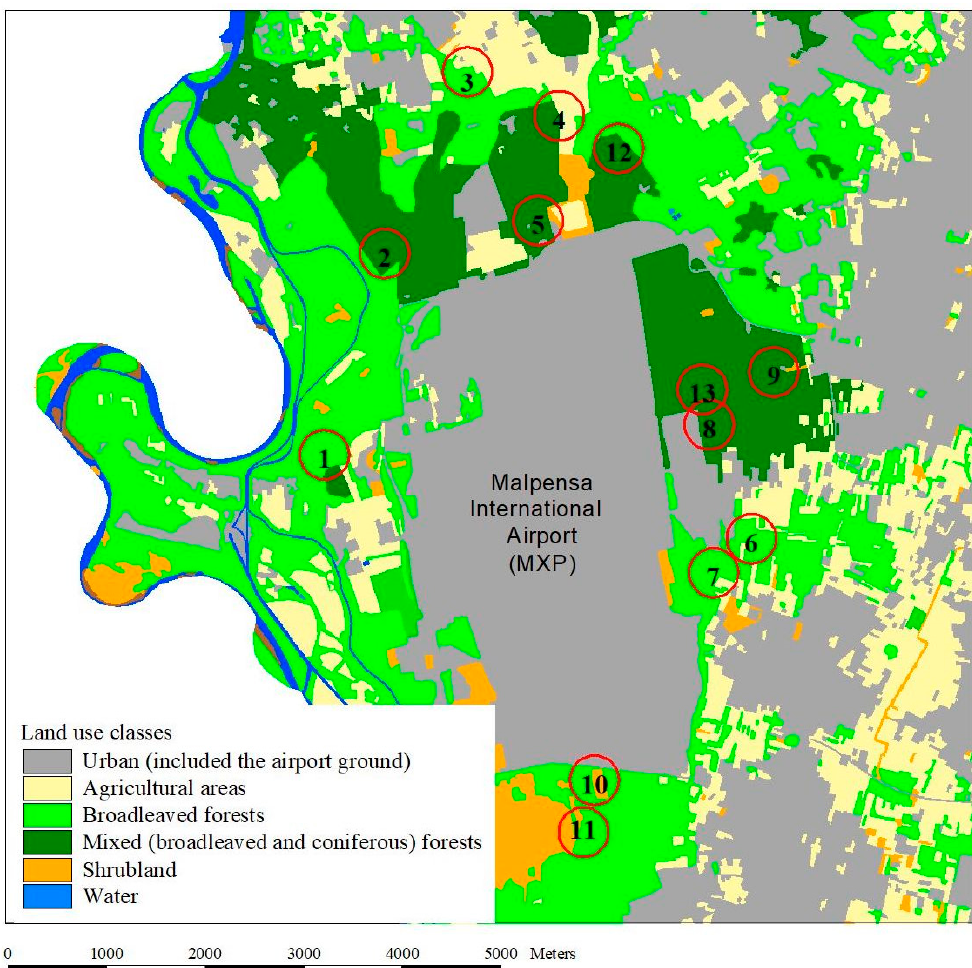
Figure 1. Study area. Map illustrating land use classes and the sampling localities in the surrounding of the Malpensa International Airport, MXP (Ferno and Somma Lombardo municipalities, Varese Province, Italy); numbers indicate the 13 sampling sites where the trial was performed.